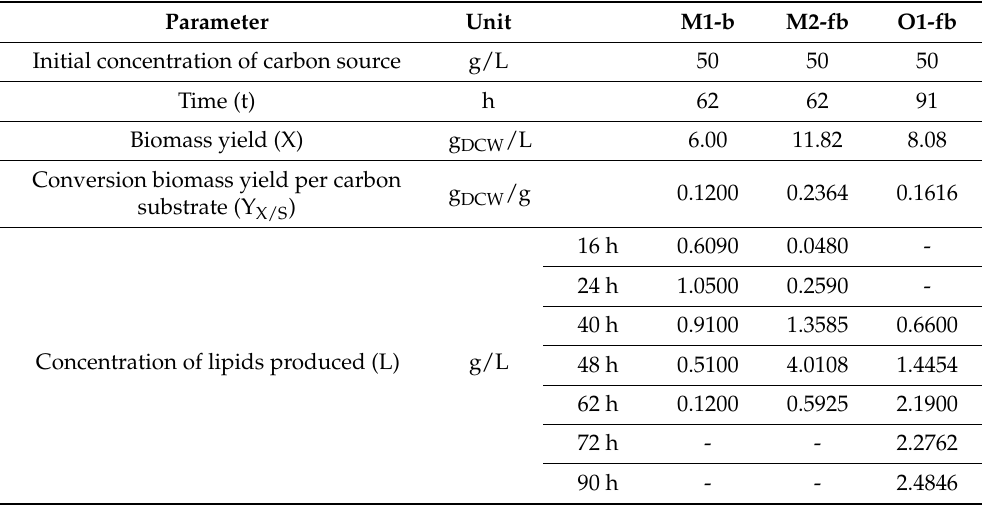
Table 1. Parameters of Y. lipolytica KKP 379 yeasts strain culture in media M1-b, M2-fb and O1-fb.